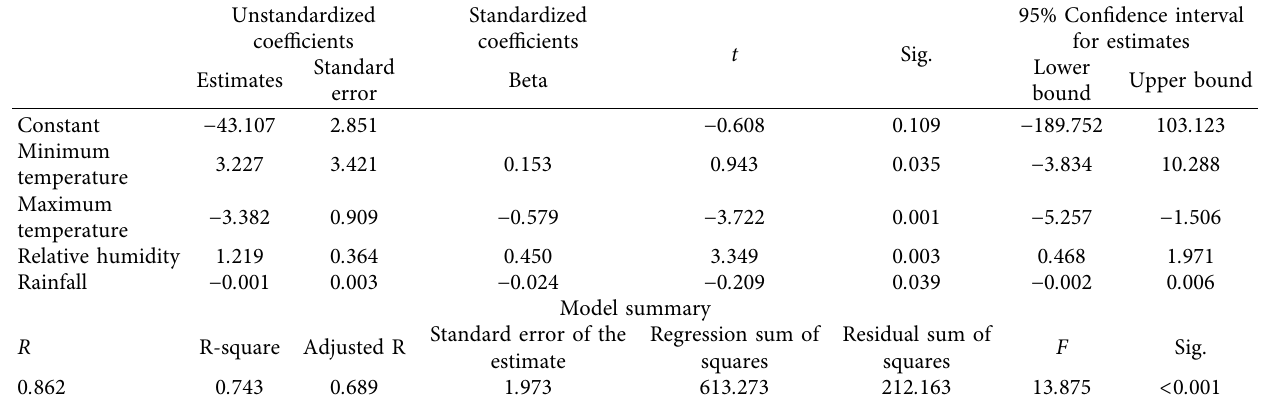
Table 3: Multiple linear regression output of cassava yield under climatic conditions.